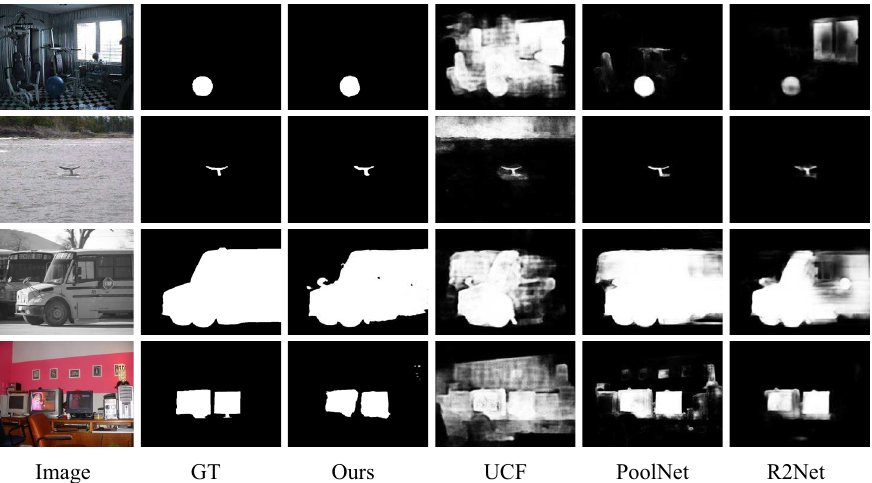
Figure 1. Illustration for saliency maps of the proposed GSCINet methods compared with other FPN-based SOD methods, including UCF [12], PoolNet [20] and R2Net [21]. Note that GT denotes ground